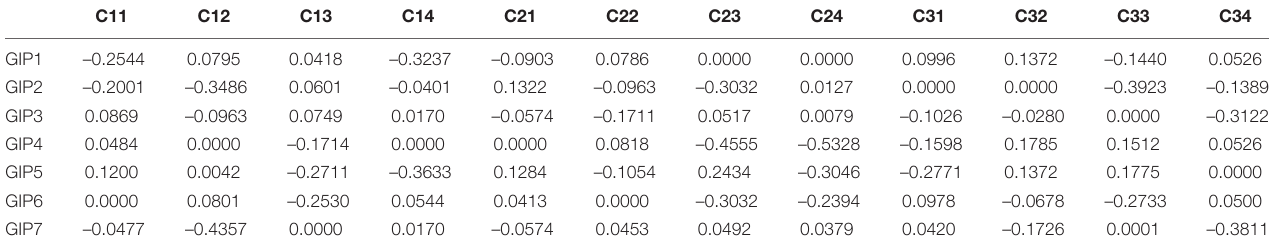
TABLE 8 | The prospect value matrix of the merged matrix.